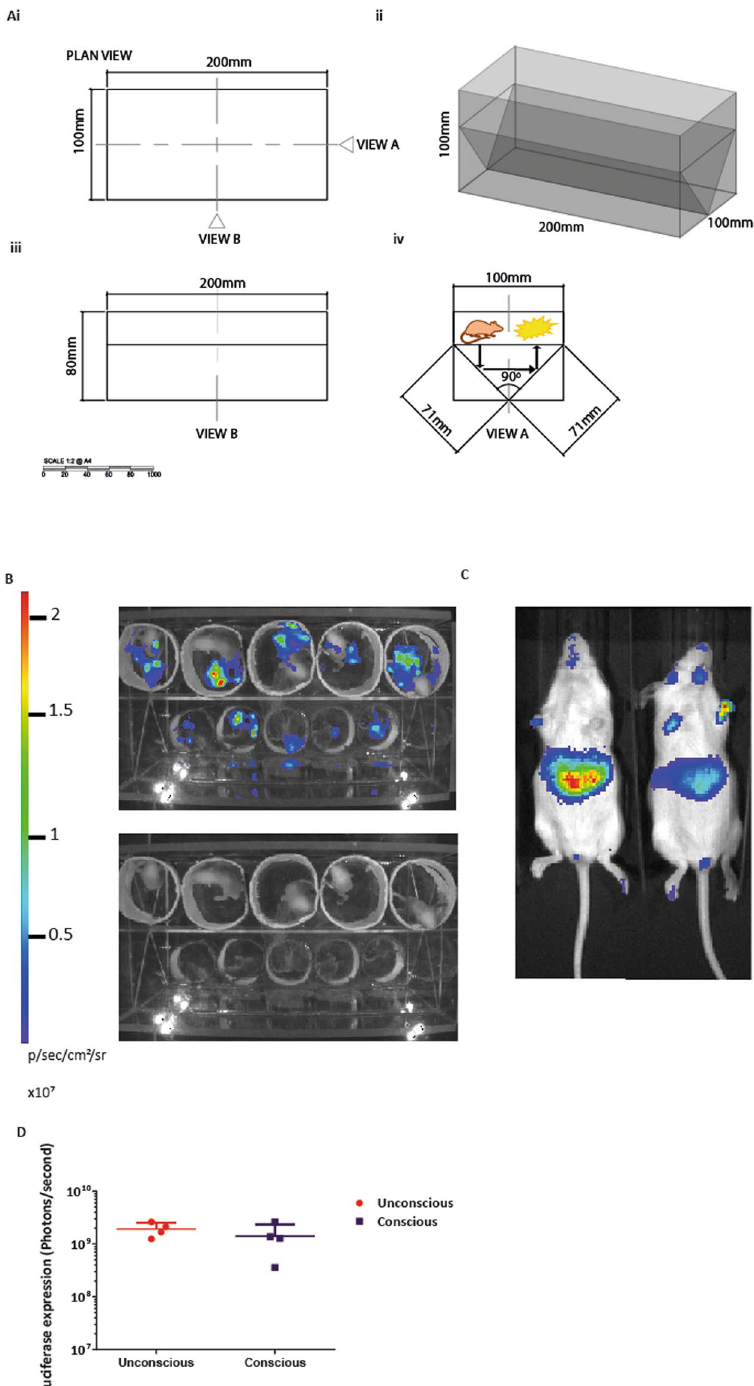
Figure 2. Whole-body bioluminescence imaging of conscious mice which have received a neonatal intravenous injection of VSV-G SFFV biosensor. (Ai) Plan view of the chamber, the scale bar represents millimetres (mm). (Aii) A 3D model with measurements (mm) of the Perspex box. (Aiii) A side-view B represents the length and depth of the chamber. (Aiv) Elevation view A shows the 90 degrees angle of the mirrors to construct a periscopic chamber to permit simultaneous collection of light emission from both ventral and dorsal surfaces, shown by the arrows. Mice were administered with VSV-G SFFV lentiviral vector intravenously at birth (n = 8). (B) Mice were imaged while conscious using the Perspex chamber, 5 at a time as neonates. The top image shows the whole-body bioluminescence and the lower image shows the mice in the chamber. The luciferase expression obtained from the conscious mice in the Perspex chamber was quantified by adding the expression profiles from the two planes. (C) Post weaning the mice were randomly split into two groups, where half of the mice were imaged unconsciously (not in the Perspex chamber). (D) There was no significant difference of luciferase expression between the conscious and unconscious mice, P = 0.657, mean + / −